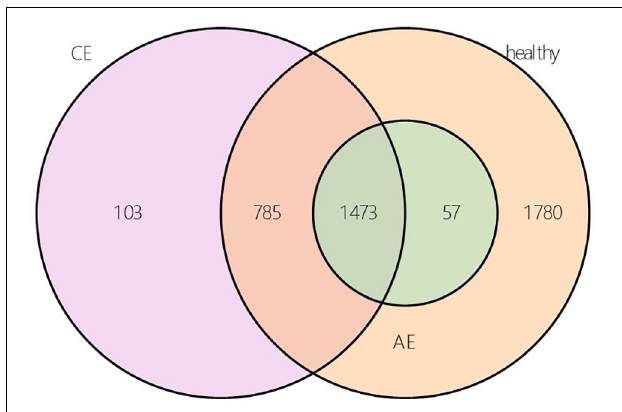
FIGURE 2 | Operational taxonomic unit (OUT) Venn diagram of alveolar echinococcosis (AE) group, cystic echinococcosis (CE) group, and healthy group in species